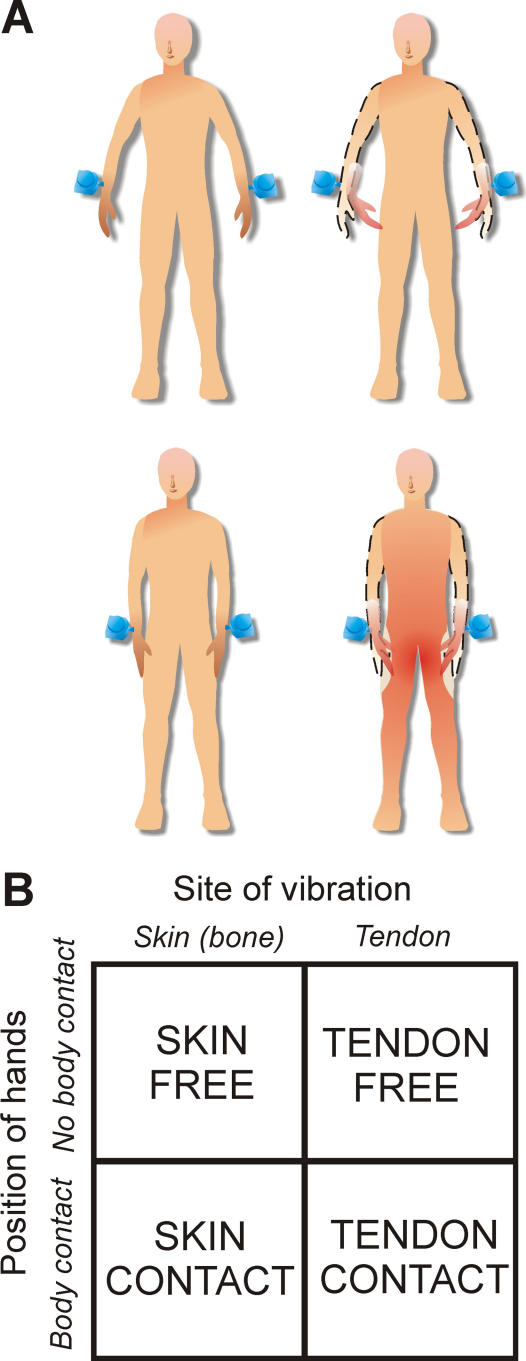
The Position of the Two Hands Relative to the Body and the Factorial Design of the ExperimentWhen the palms of the hands were in contact with the body, the vibration of the two wrists elicited the illusion that the wrists were passively flexing and the waist and hips were shrinking (A, lower right). When the hands were not in contact with the body, the vibration of the wrists only elicited the illusion that the hands were flexing (A, top right). In two additional conditions, we vibrated the skin over the styloid bone beside the tendon, which does not elicit any illusions (A, top left and lower left). The neural effect of the shrinking-body illusion can be modelled as the interaction term between hand position and site of vibration in a 2 × 2 factorial design (see [B], [tendon contact– skin contact] – [tendon free – skin free]).